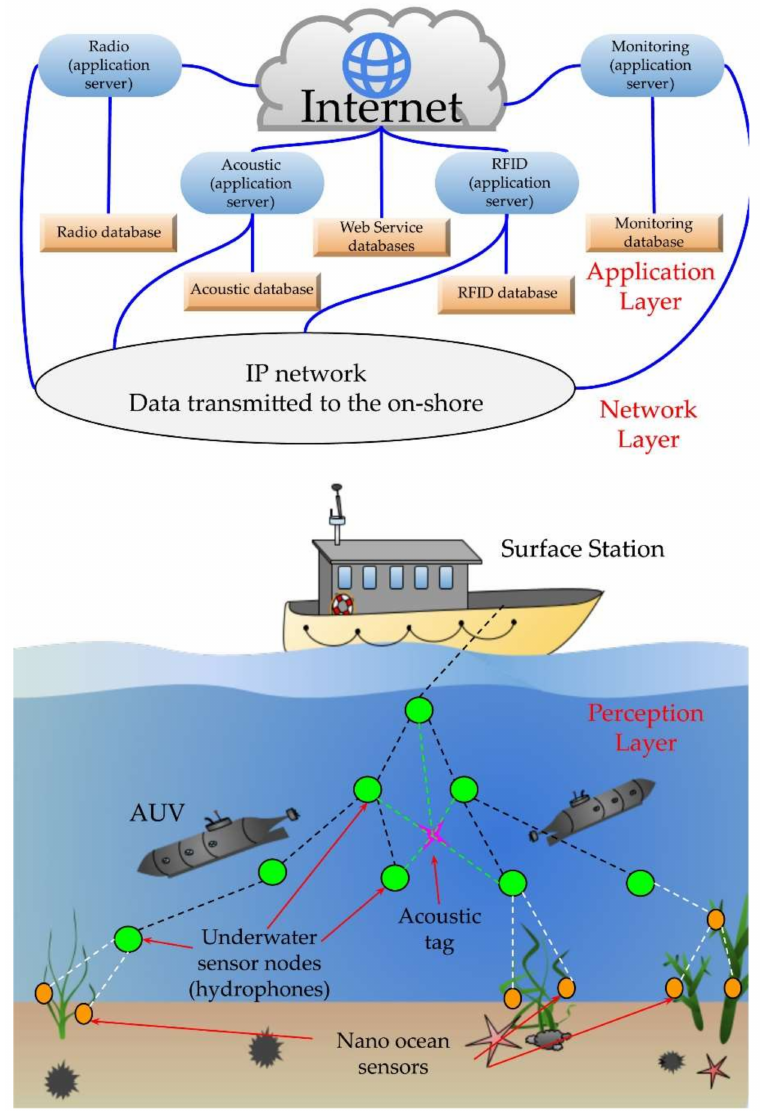
Figure 6. Functionality-based MIoT